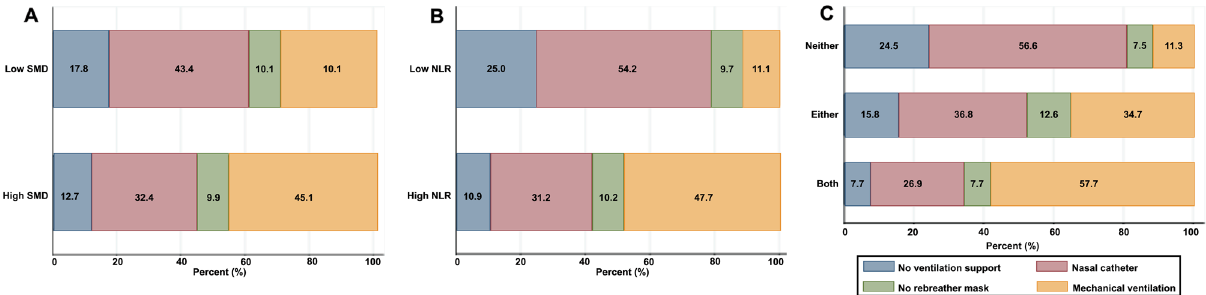
Figure 3. Supporting ventilatory use according to: ( A ) skeletal muscle radiodensity; ( B ) neutrophil-to- lymphocyte ratio; and ( C ) skeletal muscle radiodensity and neutrophil ‐ to ‐ lymphocyte ratio composite score of patients with COVID-19. Abbreviations: SMD: Skeletal muscle radiodensity; NLR: Neutrophil-to-lymphocyte ratio.